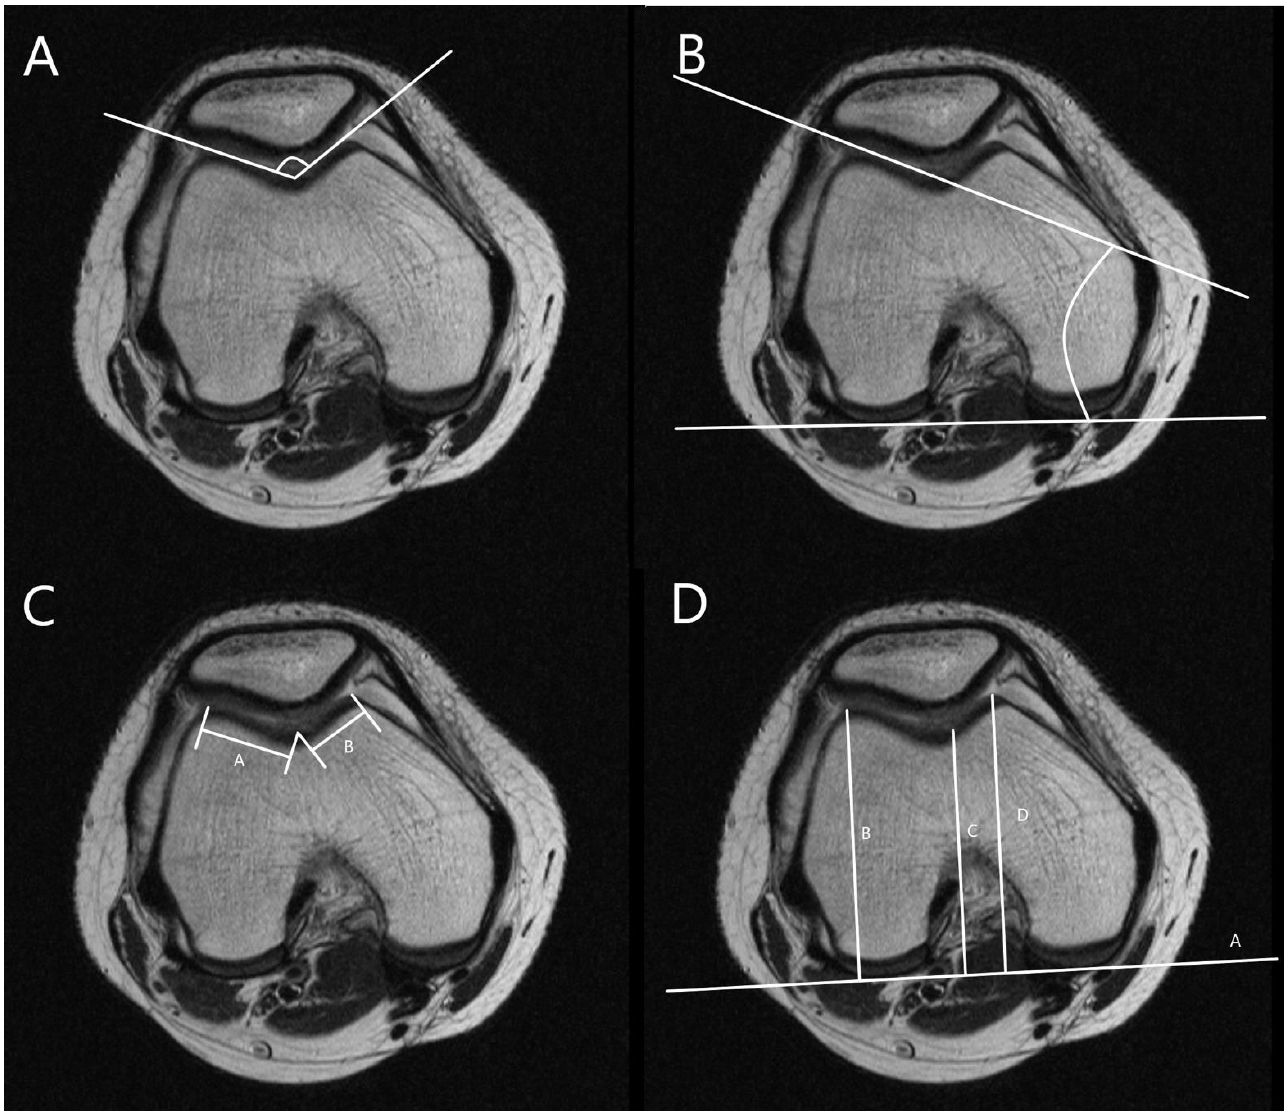
Figure 2. Measurements for trochlear morphology. ( A ) Measurement of sulcus angle (SA), the angle between slopes of the medial and lateral trochlea. ( B ) Measurement of lateral trochlear inclination (LTI), the angle between a line along with cartilage of lateral trochlear facet and a line along with posterior aspects of femoral condyles (posterior condylar axis). ( C ) Measurement of trochlear facet symmetry (TFS), the ratio of the length of medial trochlear facet (line B) to that of lateral trochlear facet (line A) [B/A]. ( D ) Measurement of femoral depth (FD), distance C between the deepest point of the trochlear sulcus and posterior condylar axis subtracted from a mean anteroposterior distance of medial and lateral femoral condyles (lines B and D) [B + D/2 − C].